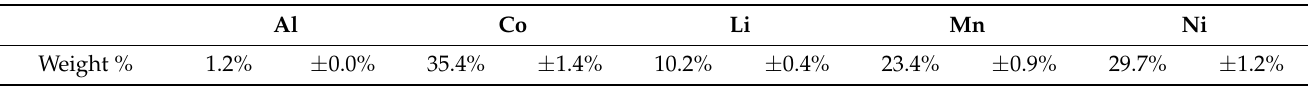
Table 1. Average metal content and standard error of the black mass powder by weight %, adapted from Punt et al.